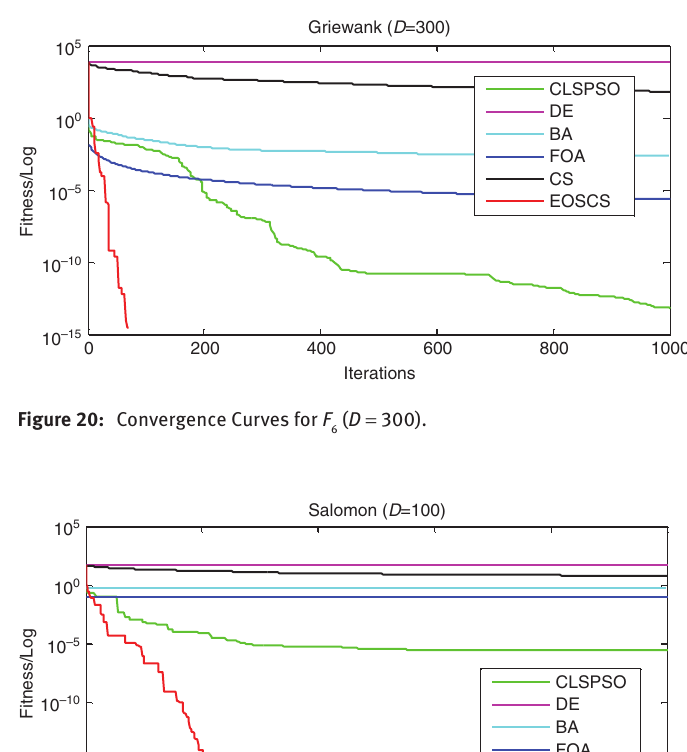
Figure 21: Convergence Curves for F